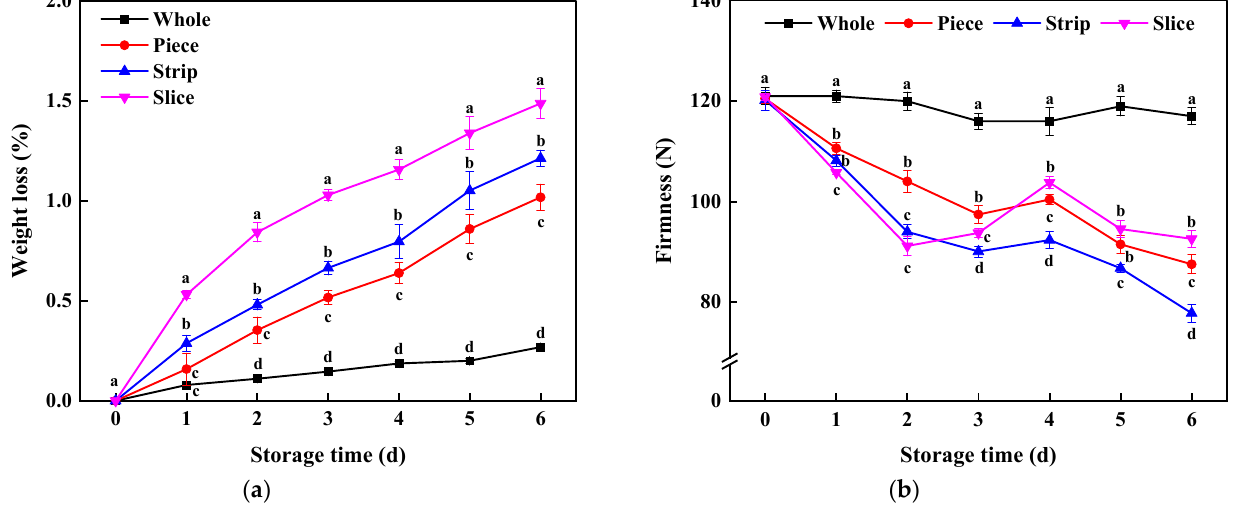
Figure 2. Effect of wounding intensities on weight loss ( a ) and firmness ( b ) of fresh-cut pumpkin during storage at 4 °C for 6 days. Vertical bars represent the standard deviation of the mean (n = 3). Different letters indicate significant differences between the groups ( p < 0.05).